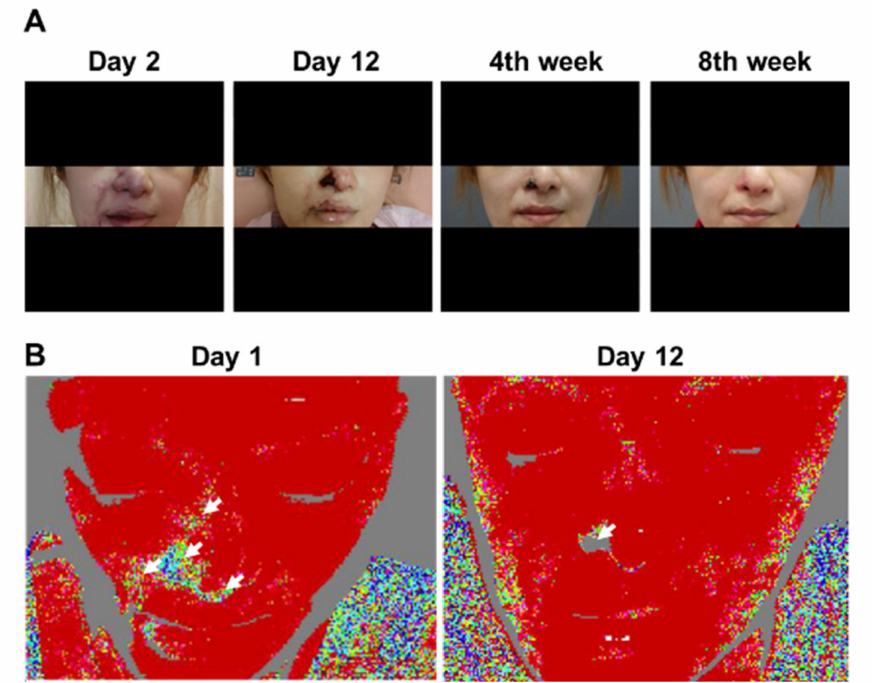
Figure 2. Clinical photographs and laser Doppler imaging of Patient 3. ( A ) Day 2 of admission; Day 12 of admission; Week 4 of follow-up; Week 8 of follow-up. Initial worsening and gradual improvement of cutaneous symptoms can be observed. Finally, only the right ala exhibited thick skin necrosis, which left an obvious scar. ( B ) Left panel: on Day 1 of admission, areas of cutaneous ischemia were clearly delineated from those without vascular occlusion. Right panel: on Day 12 of admission, although the originally affected area had not returned to its normal state of appearance, blood circulation of the other parts, except for the right ala, was